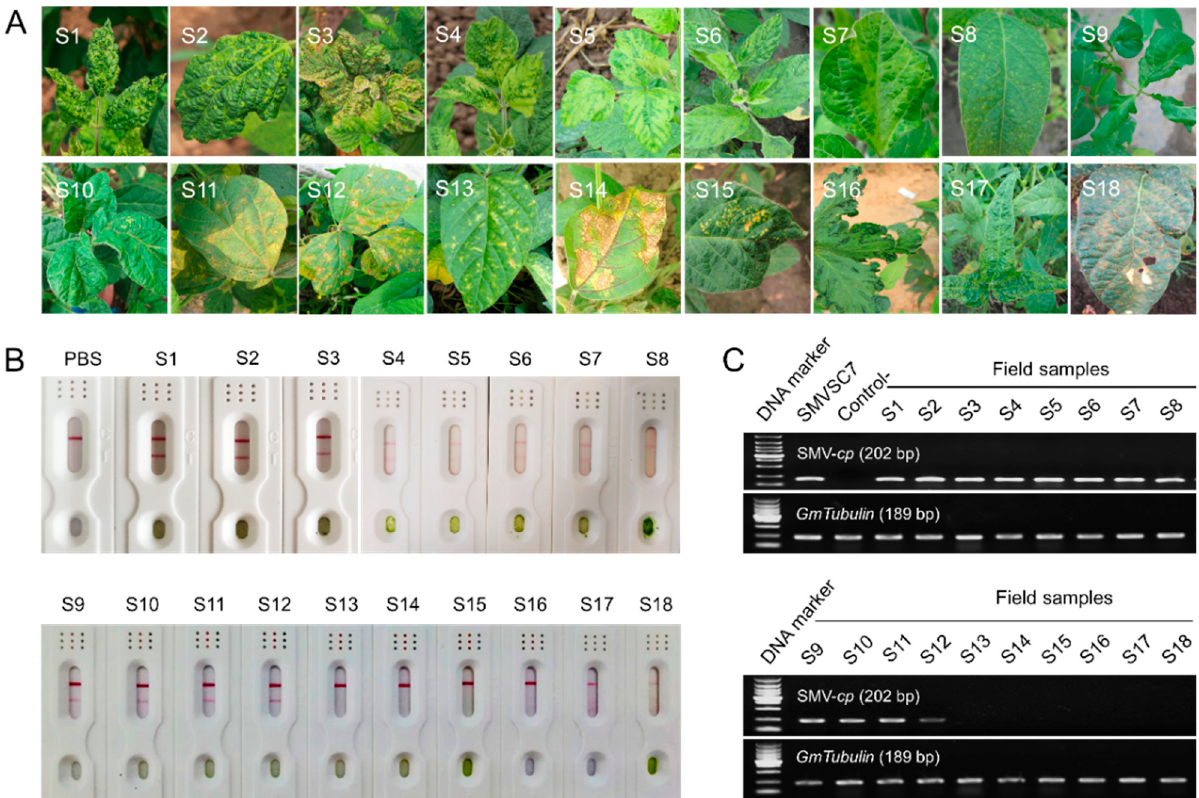
Figure 8. Field application of the SMV-GICS. ( A ) SMV-infected soybean plants in the field of the Huang-Huai-Hai main soybean production region in China; ( B ) detection of SMV in field samples using the SMV-GICA strip; ( C ) detection of SMV present in the leaves of the field plants using RT-PCR.